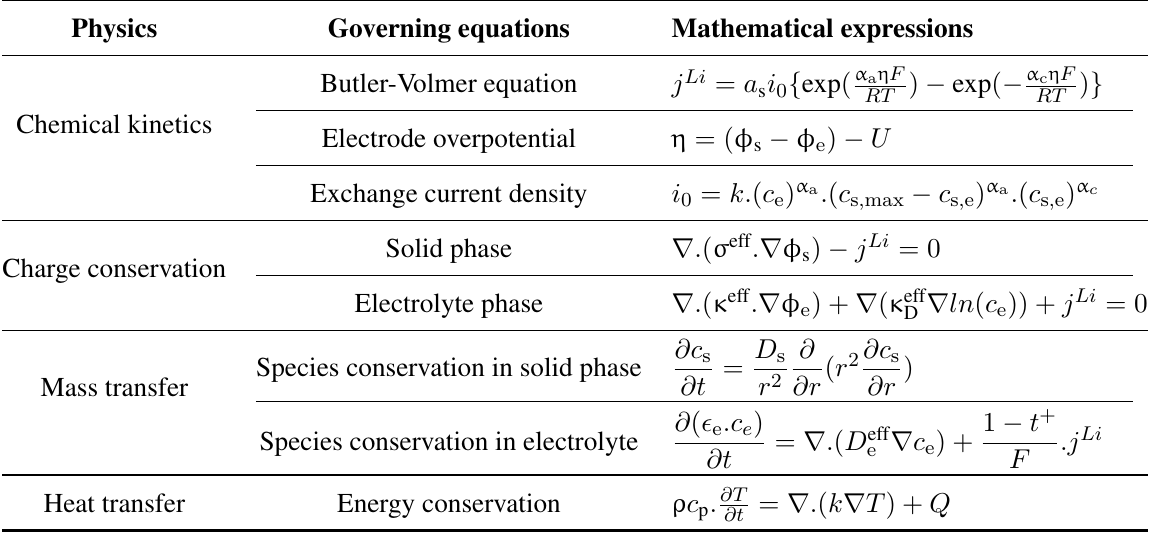
Table 1. Electrochemical-thermal